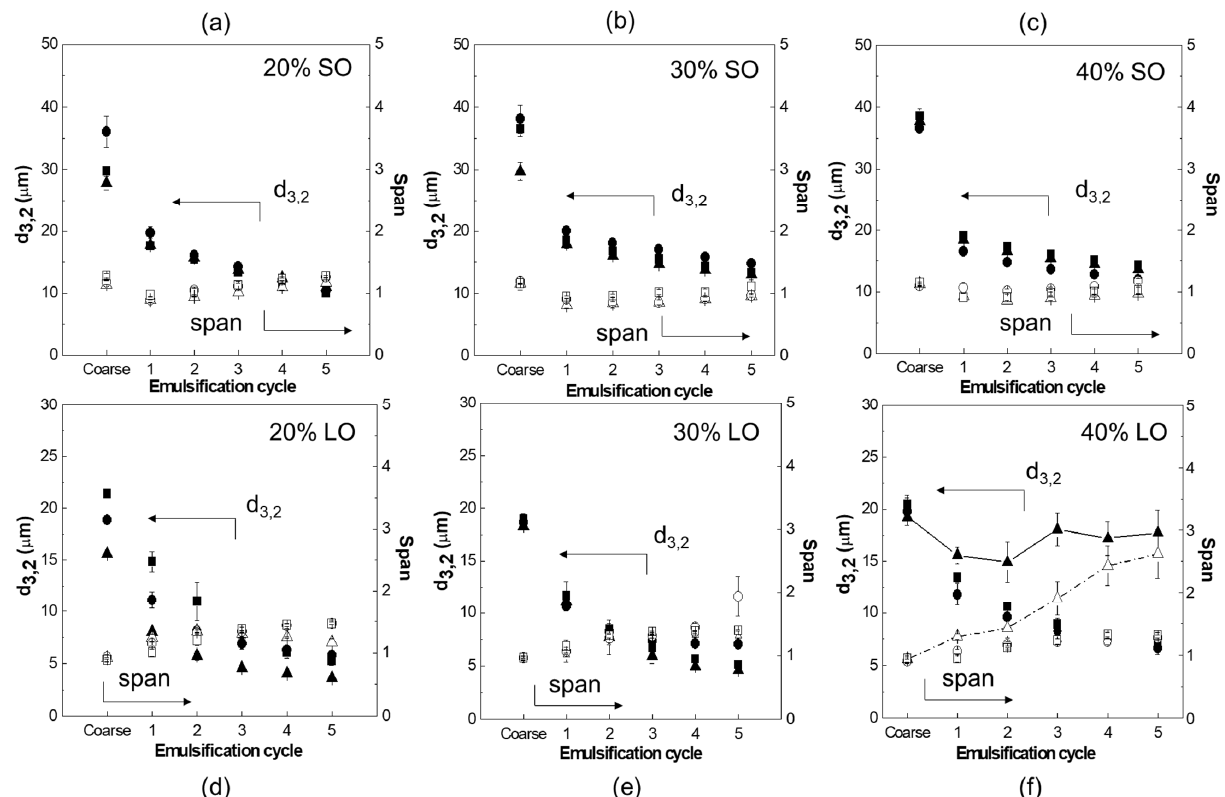
Figure 6. Sauter mean diameter (d 3,2 , full symbols) and span (empty symbols) versus the number of emulsification cycles for emulsions at different oils and oil fractions: ( a ) 20% SO (sunflower oil); ( b ) 30% SO; ( c ) 40% SO; ( d ) 20% LO (lemon oil); ( e ) 30% LO; and ( f ) 40% LO. ( d 3,2 -1% WPI (whey protein isolate); d 3,2 -1% BSFPC (black soldier fly protein concentrate); d 3,2 -2% BSFPC; span-1%WPI; span-1% BSFPC; span-2%